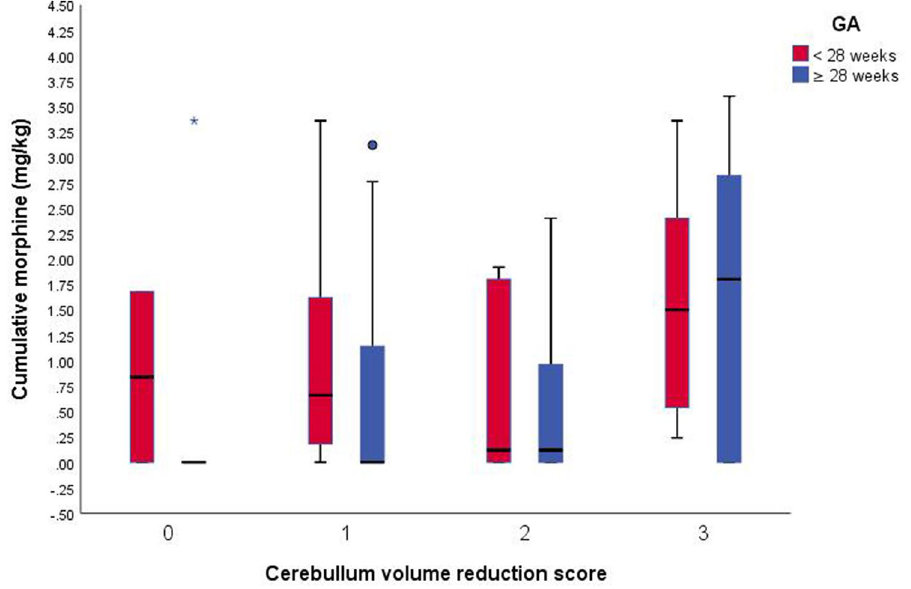
Figure 2. Cerebellar volume score by morphine exposure, adjusted for age at the time of magnetic resonance imaging and stratified by gestational age (GA) at birth (red: < 28 weeks, blue: ≥ 28 weeks). GA Gestational age.